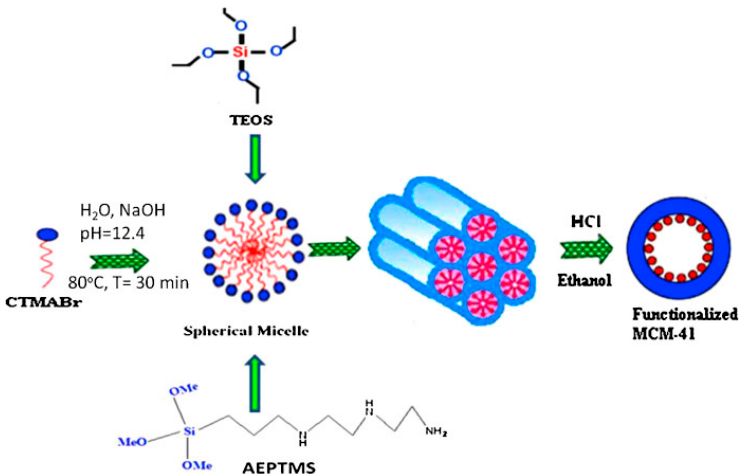
Figure 5 . Schematic illustration of reaction sequence and the structure of functionalized MCM-41.